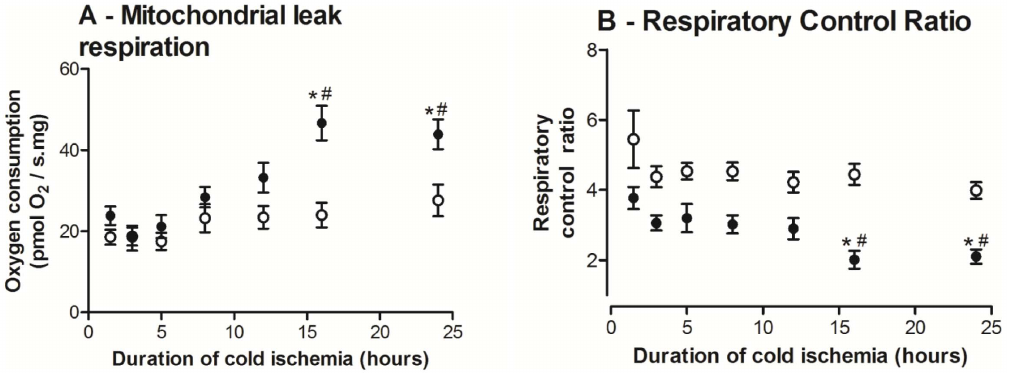
Figure 4. Mitochondrial leak respiration and respiratory control ratios (RCR) of ob/ob and lean livers following different duration of cold ischaemia (hours). A: Ob/ob livers showed increased mitochondrial leak rates with progressive cold ischaemia and increased significantly after 16 hours of cold ischaemia, while lean liver mitochondrial leak rates remained stable. B: Ob/ob livers consistently showed lower RCRs compared to lean livers and differed significantly after 16 hours of cold ischaemia. Ob/ob livers also demonstrated decreased RCR after 16 hours of cold ischaemia relative to 1.5 hours while lean liver RCR remained stable. Data are shown as mean 6 SEM (n=9 mice/group; ob/ob , closed circle; lean livers, open circle). Restricted maximum likelihood with post-hoc Tukey-Kramer analysis was performed. *, P , 0.05 (vs. lean); # , P , 0.01 (vs. 1.5 hours).